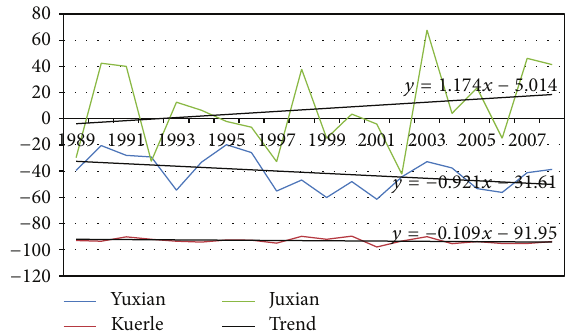
Figure 7: Precipitation recorded at the selected weather stations from 1989 to 2008.